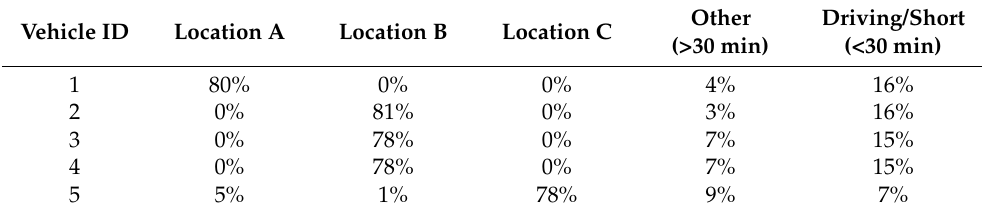
Primary dwell location: Table 5 contains the percentage of time per vehicle spent at each charger. Other dwell locations and the time spent driving are also included. The primary dwell location for vehicle 1 was A; for vehicles 2, 3 and 4 was B; and for vehicle 5 was C. Table 5. Percentage of time spent at each charger per vehicle.